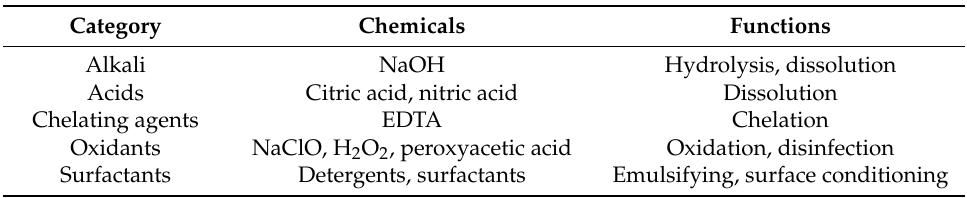
Table 2. Major chemicals for membrane chemical cleaning. Adapted from [117]. EDTA: sodium ethylenediaminetetraacetic